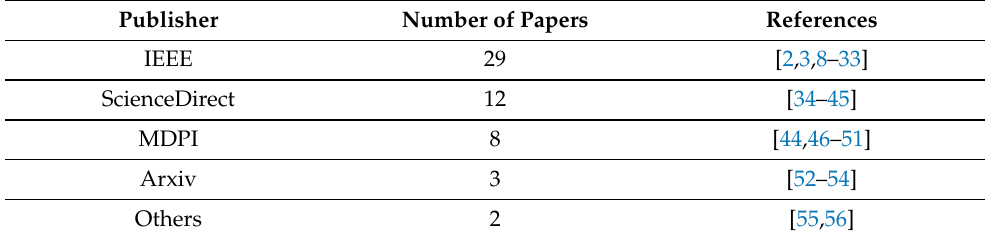
Table 1. Sources of papers for the